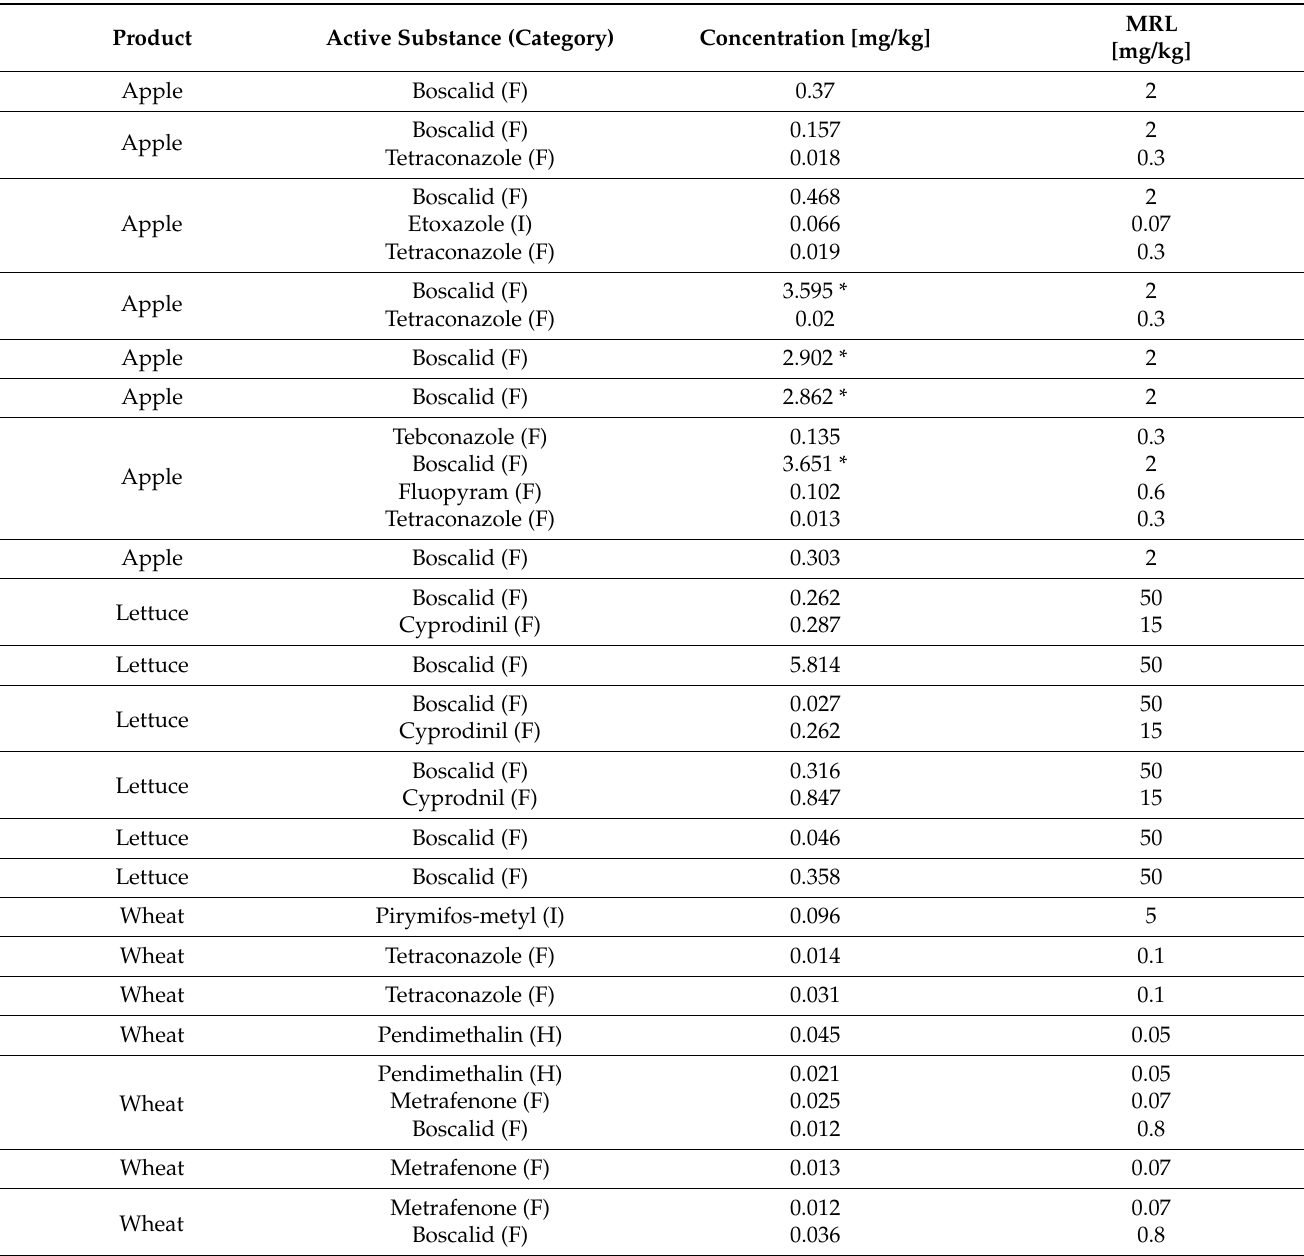
Table 5. Pesticide residues analysis in real plant